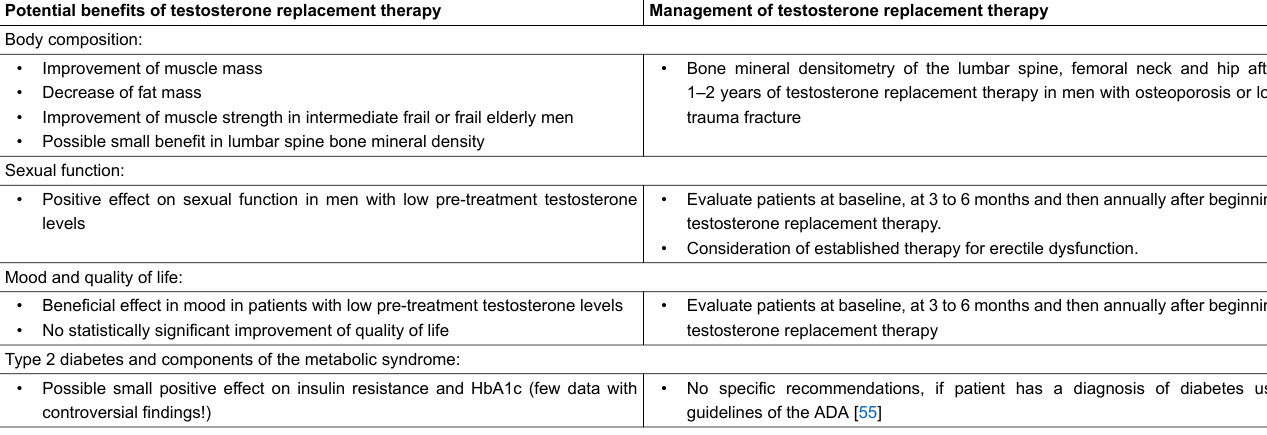
Table 1: Potential benefits and management of testosterone replacement therapy in elderly men [53,